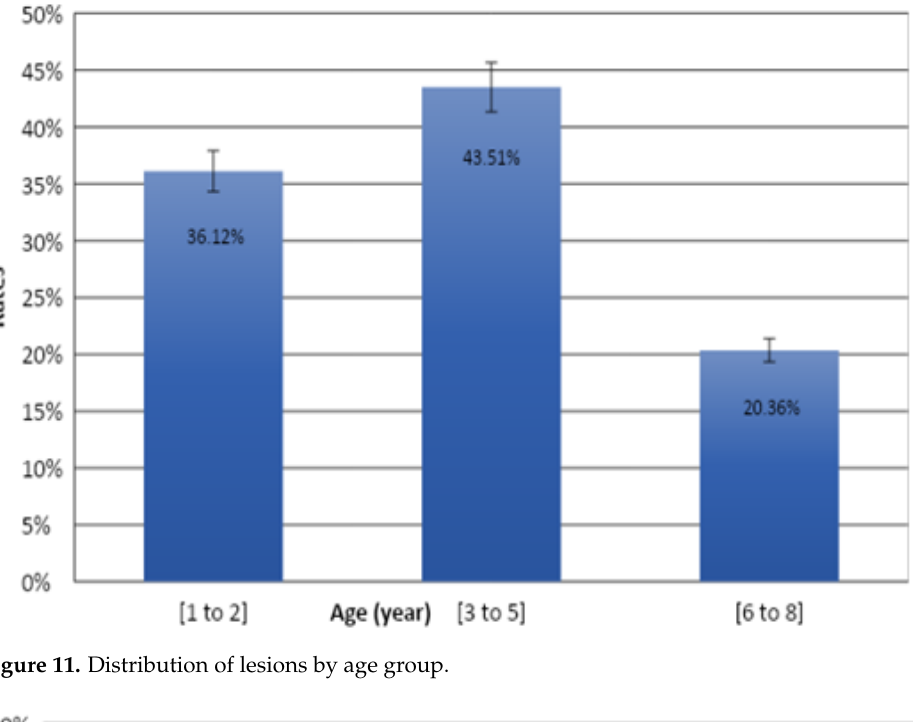
Figure 10. Distribution of lesions according to the sex of the animals.